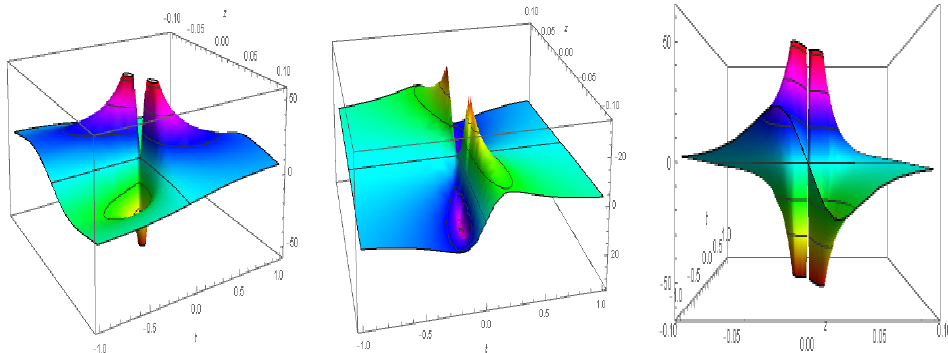
Figure 11. The GB profiles of the solution ∆ 6 in Equation (24) are made through values of κ = 5, b = 1 and ρ = 4. Three-dimensional graphs at (i) σ = 0.2, (ii) σ = 0.8 and (iii) σ = − 0.1.